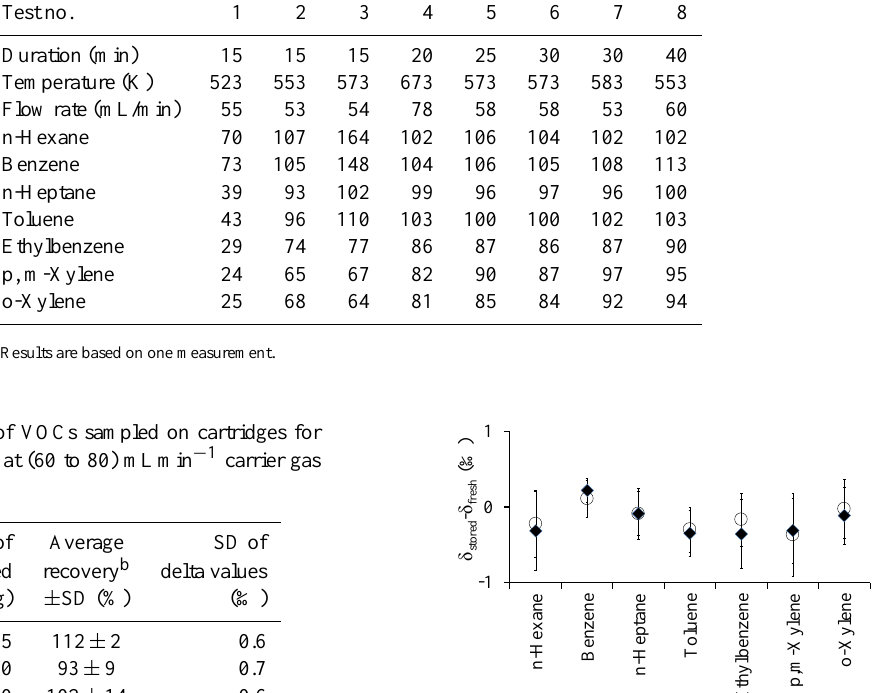
Table 2. Recoveries of VOCs (%) under different desorption conditions (samples were analyzed with GC-FID or GC-IRMS) ∗ . Test no.